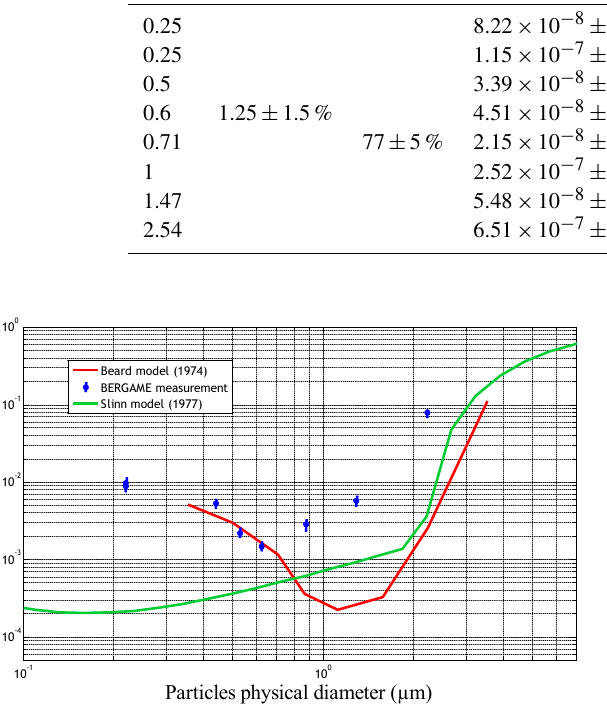
Figure 10. Comparison of our measurements for a drop of 1.25mm diameter with the results of the models of Beard (1974) and Slinn